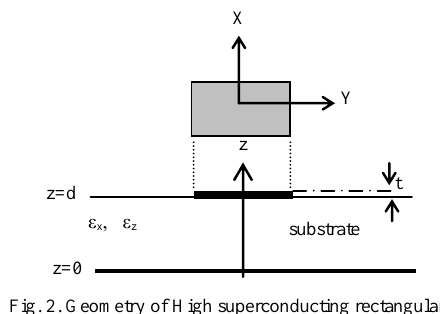
Fig. 2. Geometry of High superconducting rectangular microstrip patch on uniaxial substrate The transverse field components in the j th layer can be obtained using the Fourier transform formulation